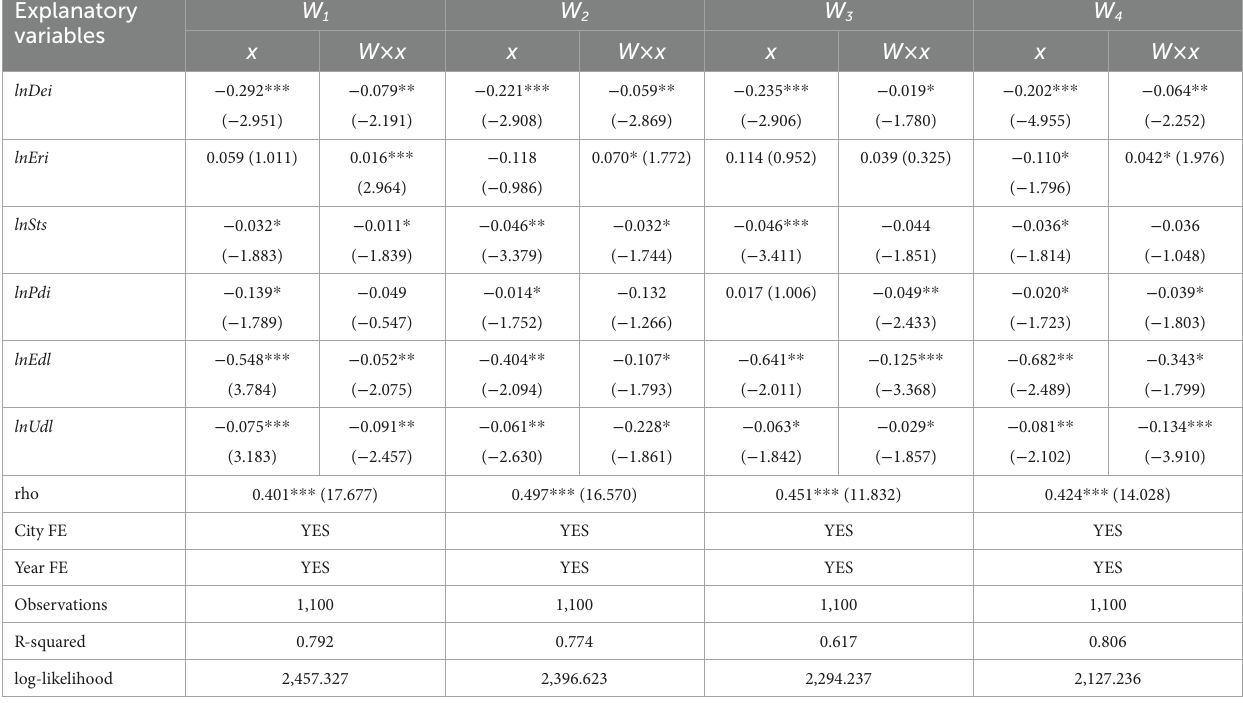
TABLE 8 Regression of